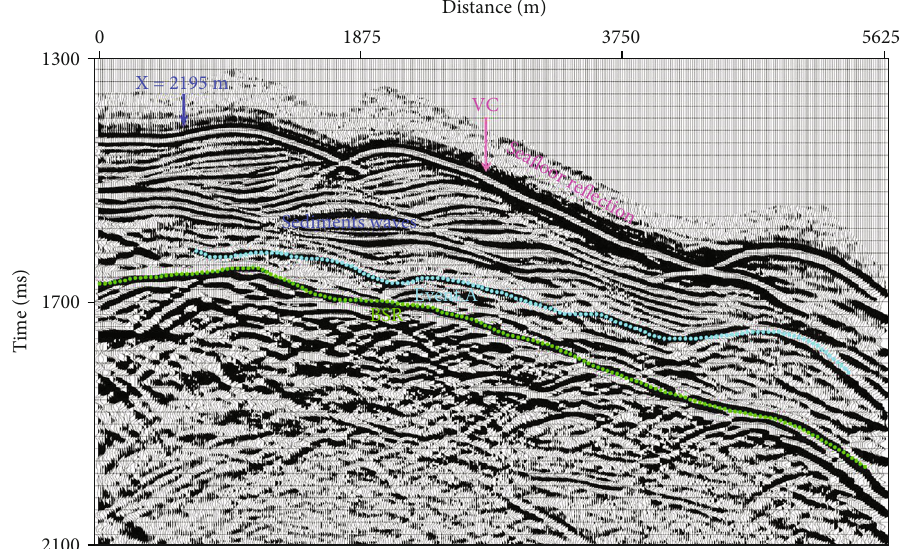
Figure 6: Ghost re fl ection imaging result with the above-mentioned virtual SSP